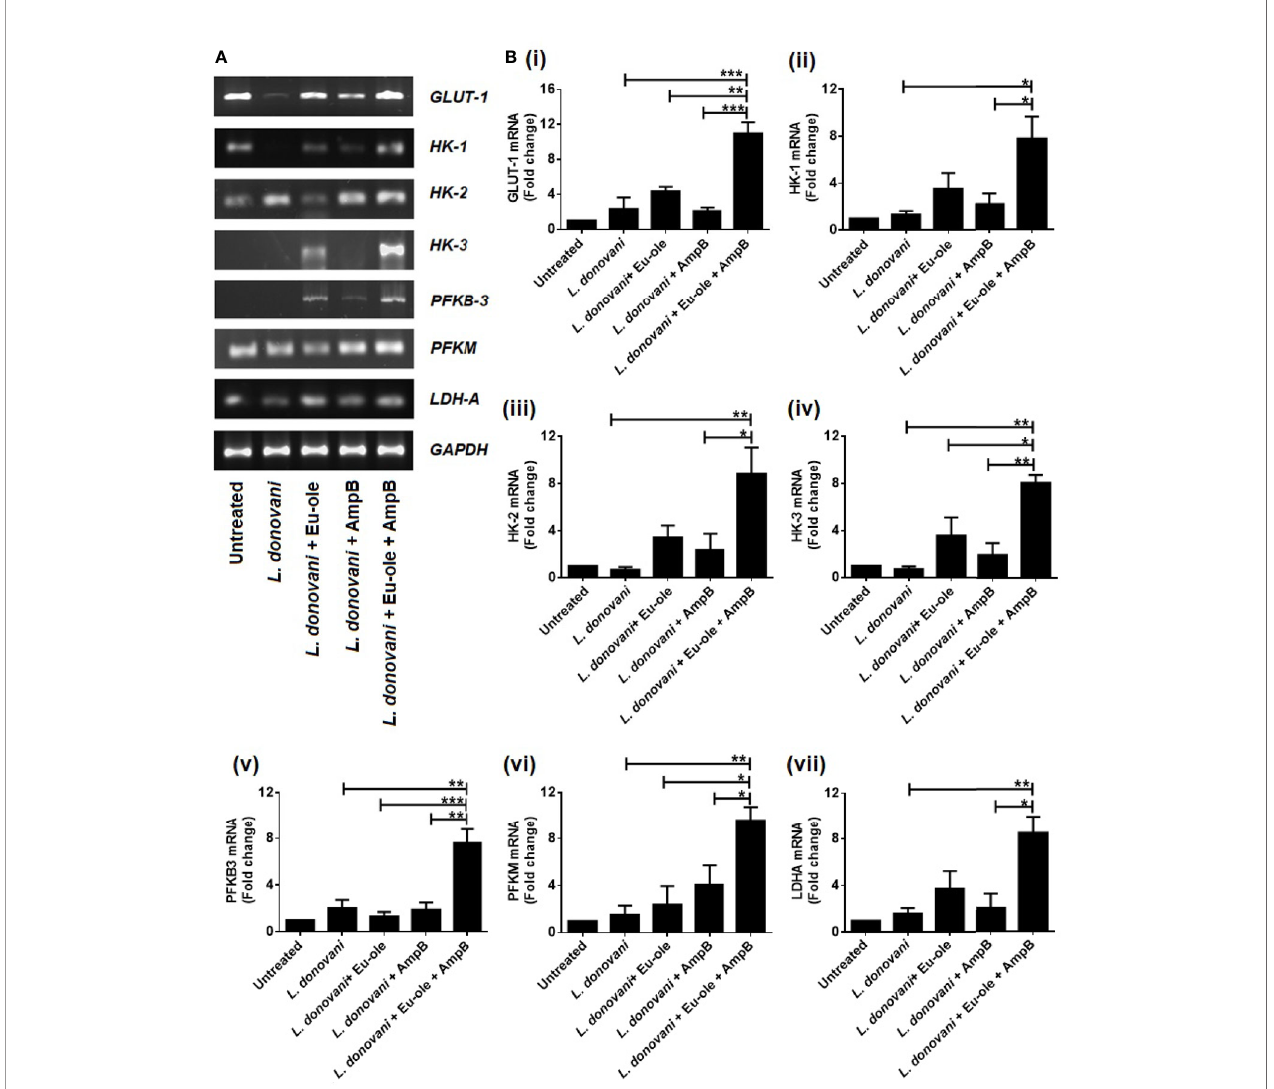
FIGURE 1 | Alteration in glycolytic enzymes pro fi le during combinatorial treatment. Peritoneal macrophages infected with L. donovani (1:10 ratio). After 24 hr of post infection, treatment was given to infected macrophages and after 6 hr, cells were collected in Trizol to determine the mRNA expression of glycolytic enzymes by RT PCR (A) . and the transcription levels of glycolytic genes GLUT-1, HK1, HK-2, HK-3, PFKM, PFKB3 and LDHA were analysed by quantitative Real Time PCR ( B i-vii). The results were expressed as mean ± SD. *p < 0.05, **p < 0.01, ***p < 0.001, signi fi cant differences between the indicated